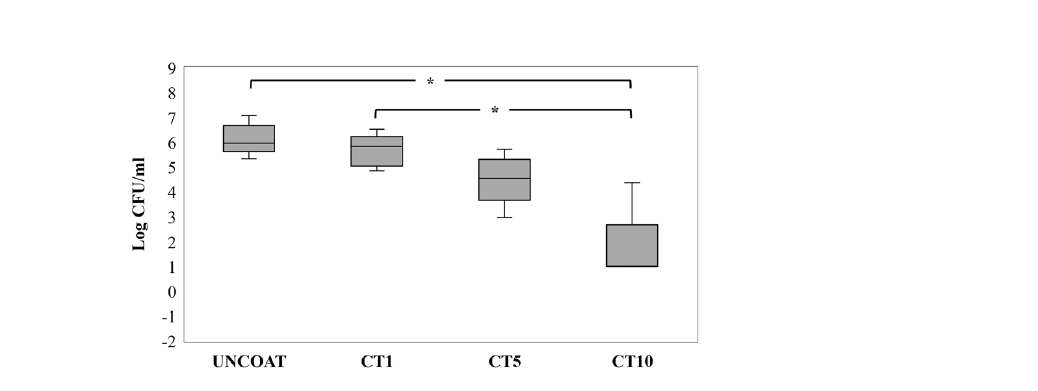
Figure 6. The number of viable bacteria (represented as Log CFU/mL) on the surface of the uncoated NiTi alloy sample and the GO/AgNPs coated NiTi alloy samples using different coating times. Asterisk (*) represents a significant difference ( p < 0.05) by Kruskal–Wallis H test and Dunn’s